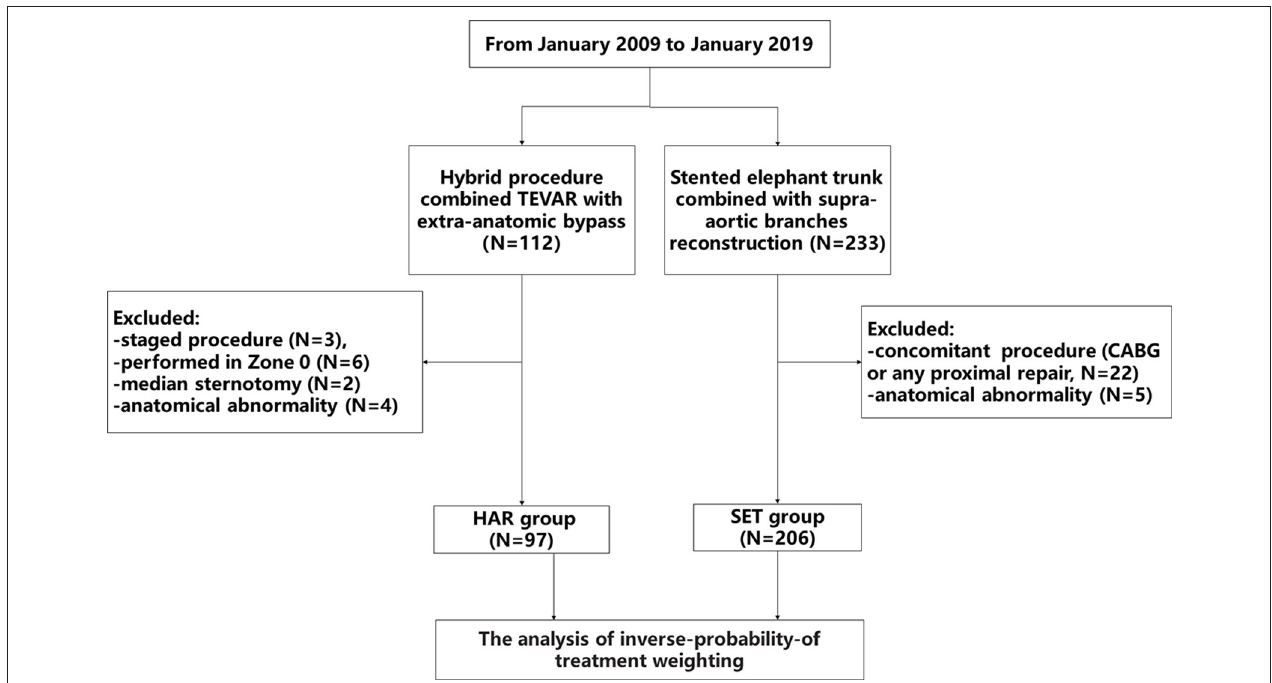
FIGURE 1 | The detailed flow chart of